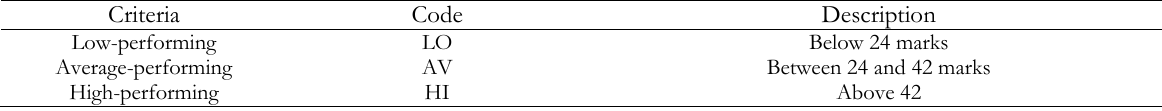
Table 1. Classification of learners’ achievement test scores Criteria